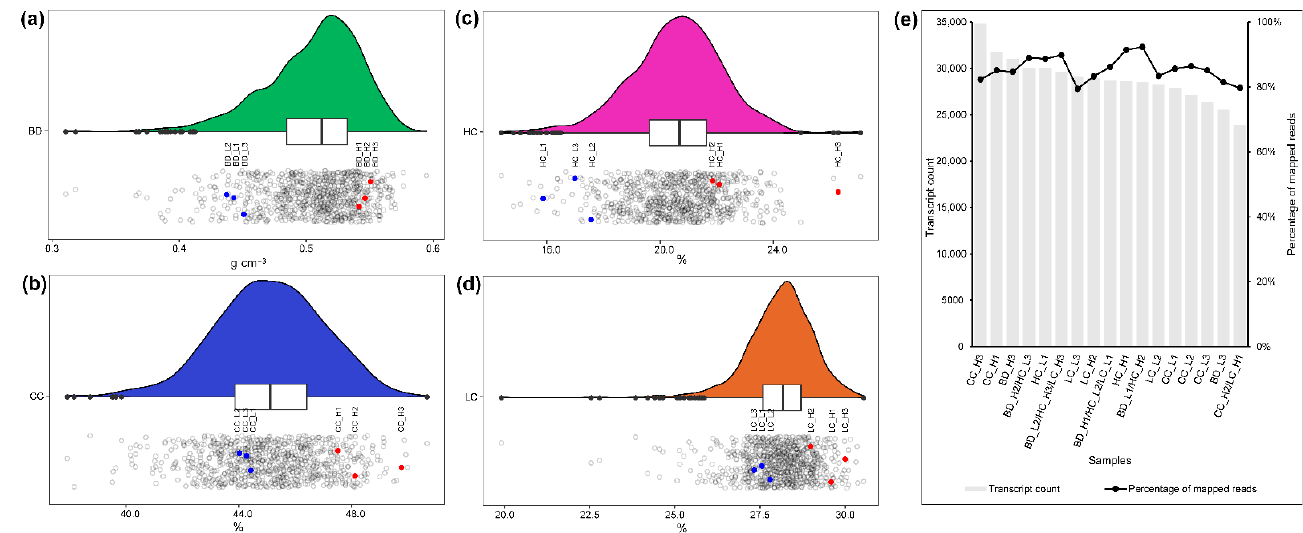
Figure 1. Variation of wood properties and selection of highly contrasting phenotypes of E. urophylla × tereticornis hybrids in an experimental population in southern China. Panels ( a – d ) show the distribution of phenotypic variation of BD ( a ), CC ( b ), HC ( c ), and LC ( d ) from 777 trees. The upper portion of panels a-d illustrate the approximately normal distribution of phenotypes in each trait ( x -axis boxes indicate the interquartile range), while the lower proportion of panels are jittered scatterplots with the blue and red dots indicating three high (H) and three low (L) phenotypes selected for each trait. Panel ( c ) shows the sequence quality of RNA-seq performed on 17 samples, including transcript count and percentage of reads that mapped to the E. grandis reference genome. Note that the suffixes H and L indicate “high” and “low” phenotypes, with five trees representing two or three traits. For example, BD_L2/HC_H3/LC_H3 is a sampled tree that represents three traits (low BD, high HC, and high LC).